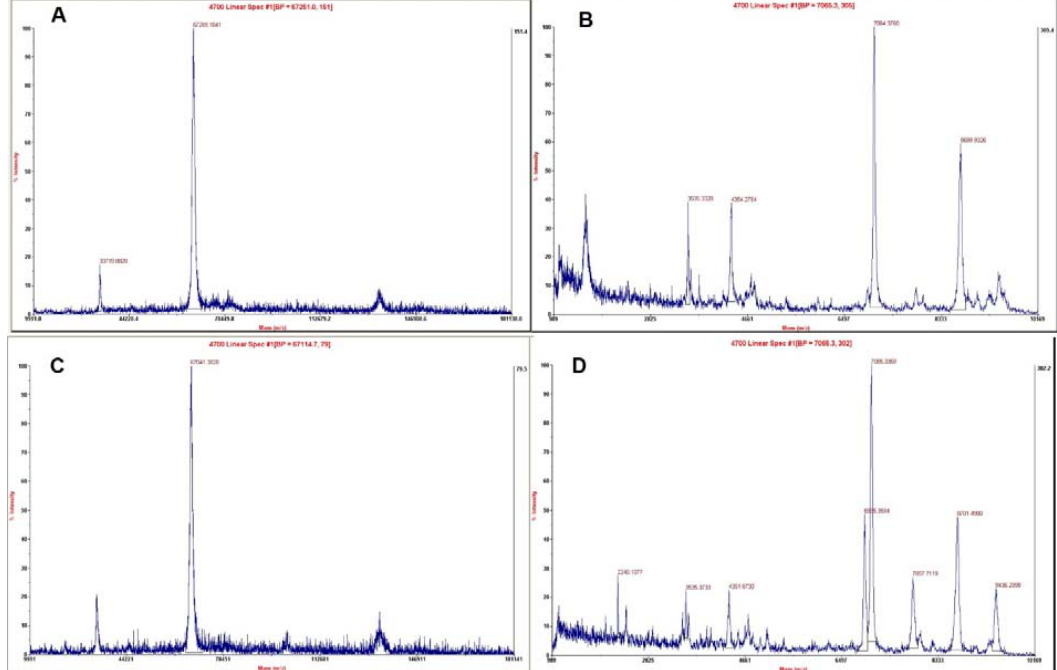
Fig. 4. MALDI-TOF spectrum of Silica NPs after treatment with human plasma, both small and large range of m/z were represented using α-Cyano-4-hydroxycinnamic acid and sinapinic acid respectively. (A, B) Bare-SiNPs protein corona (HP 10%), (C, D) Bare- SiNPs protein corona (HP 55%).